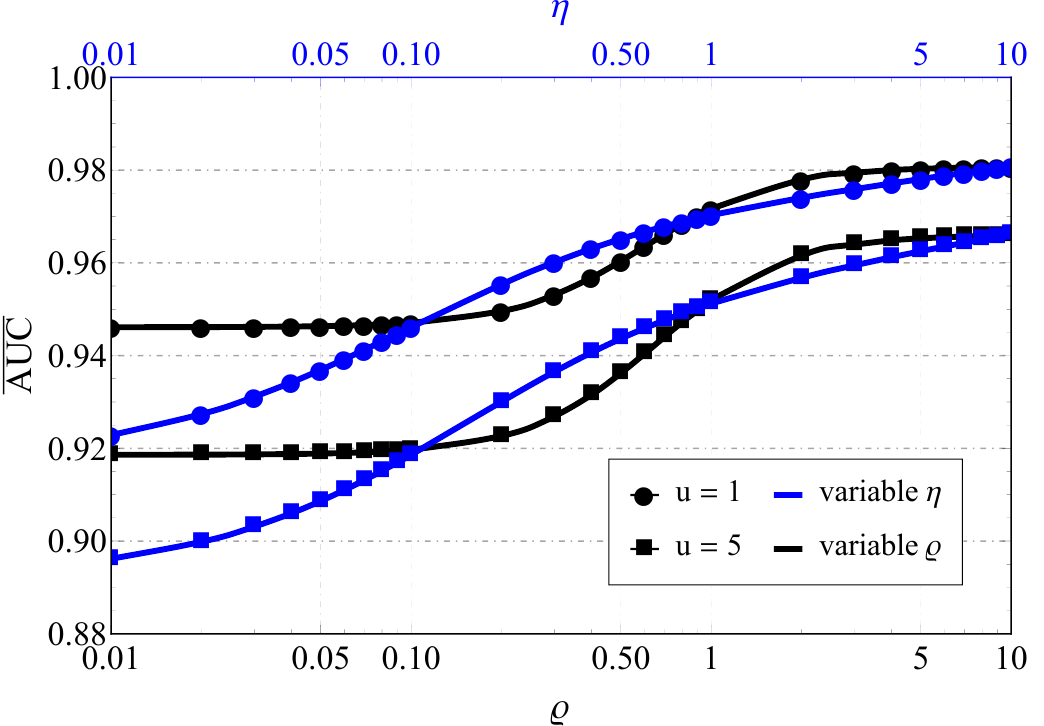
Figure 5. Average AUC comparison for the Fluctuating Beckmann (with κ = 1, m = 1, µ = 1, ¯ γ = 15 dB): blue lines—variable η with ρ 2 = 0.1, black lines—variable ρ with η =